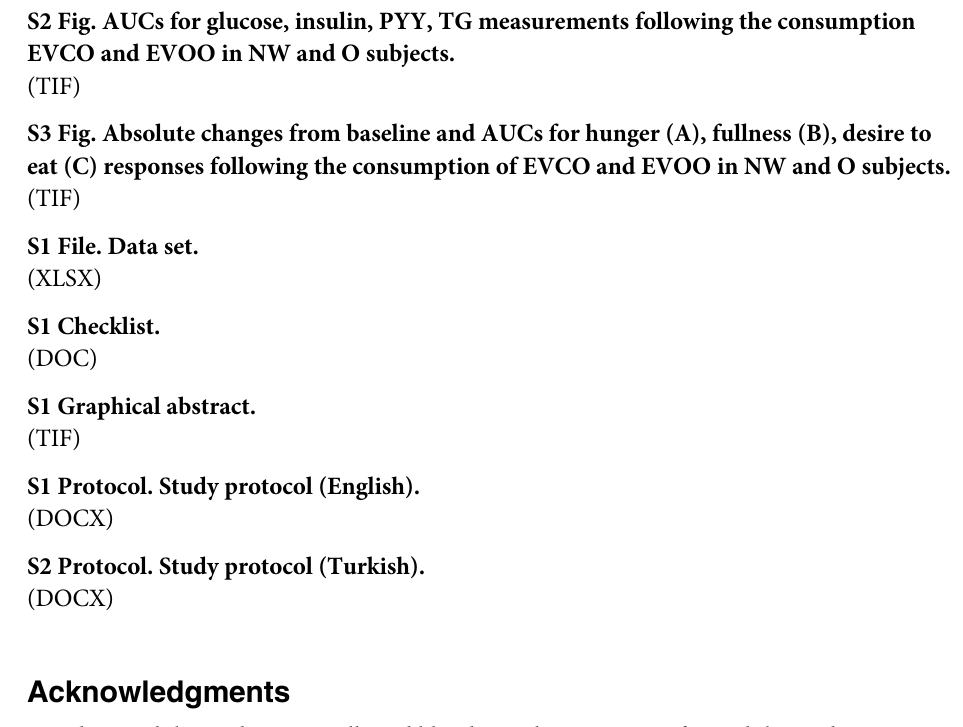
S1 Fig. AUCs for EE measures following the consumption of EVCO and EVOO consump- tion in NW and O subjects. S2 Fig. AUCs for glucose, insulin, PYY, TG measurements following the consumption EVCO and EVOO in NW and O subjects. S3 Fig. Absolute changes from baseline and AUCs for hunger (A), fullness (B), desire